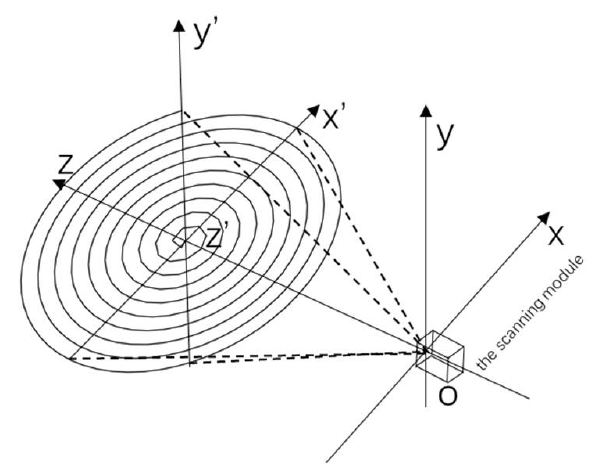
Figure 4. The geometry diagram of spiral scanning.